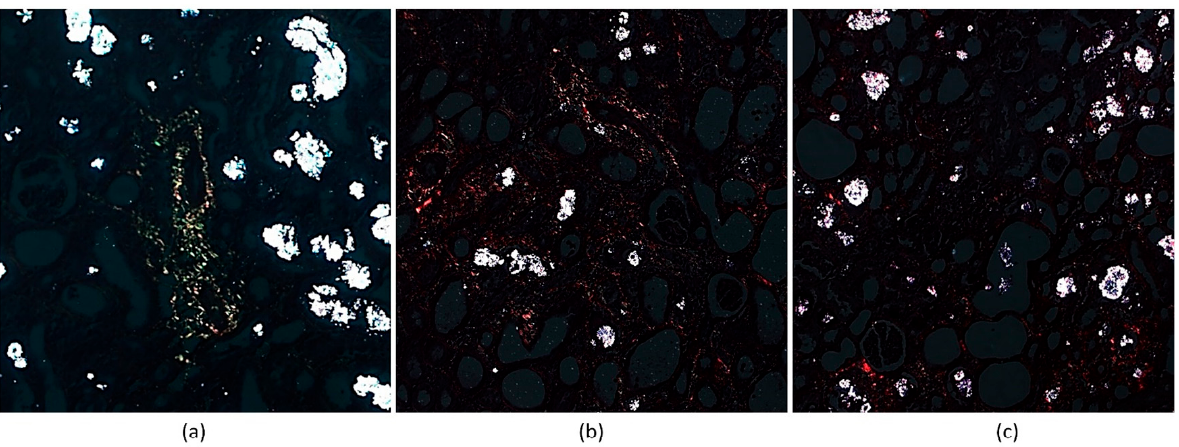
fiber in all the analyzed groups occurred as a result of a fibrotic process (Figure 7).